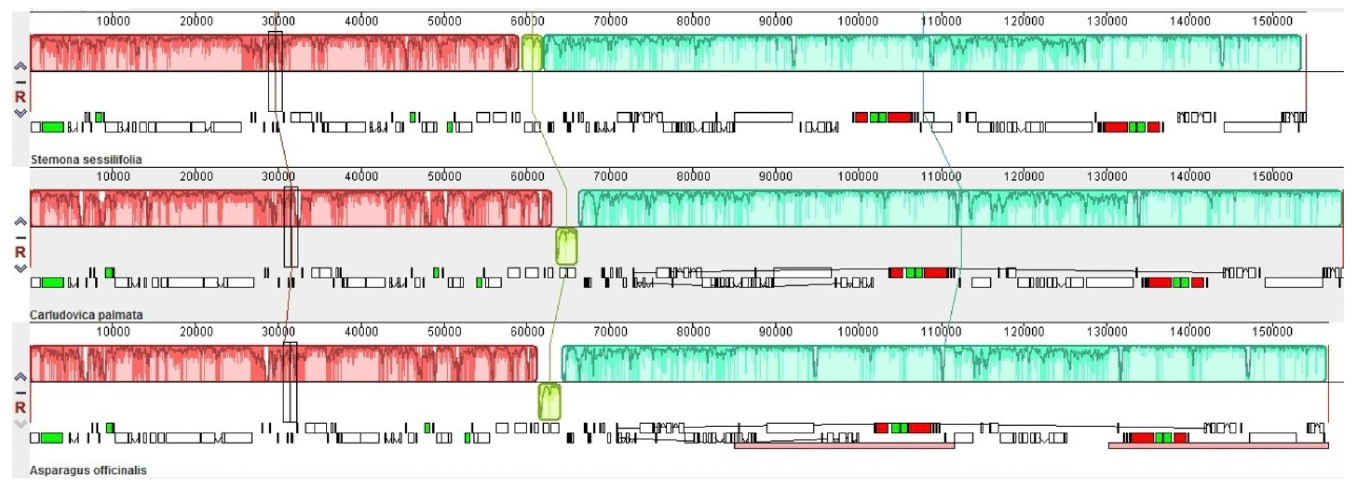
Fig 4. Comparison of the three chloroplast genomes using the MAUVE algorithm. Local collinear blocks were colored to indicate syntenic regions, and the histograms within each block indicated the degree of sequence similarity.